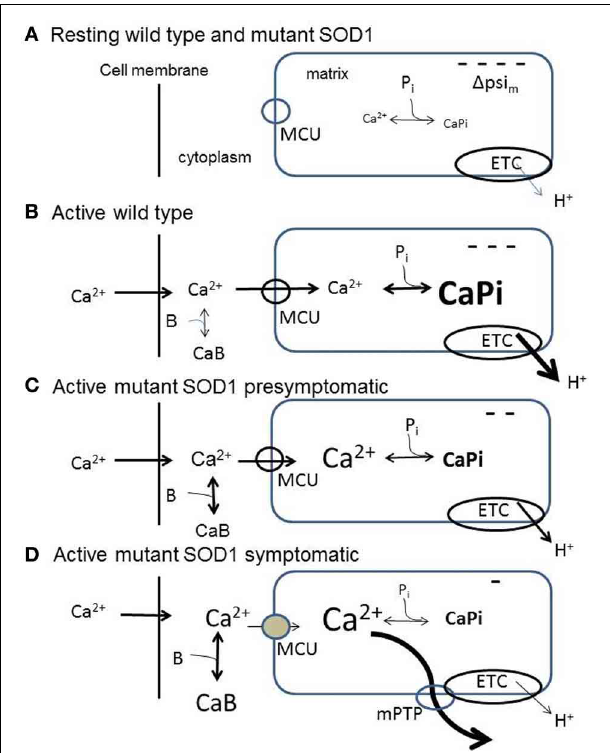
FIGURE 1 | Diagrams summarizing aspects of mitochondrial handling of stimulation-induced Ca 2 + loads in wild-type (B) and in presymptomatic (C) and symptomatic (D) SOD1-G93A motor neurons, inferred from measurements in somata and motor terminals. (A) Resting wild-type and SOD1-G93A motor neurons. (cid:2)(cid:3) m is inside-negative due to H + extrusion by the electron transport chain (ETC). Pi represents dynamic phosphate-dependent matrix Ca 2 + buffering capacity. (B) Wild-type neuron buffering a large stimulation-induced Ca 2 + influx. At least 50% of this influx enters mitochondria via the mitochondrial Ca 2 + uniporter (MCU). The mitochondrial Ca 2 + influx partially depolarizes (cid:2)(cid:3) m , thus increasing ETC activity. Matrix Ca 2 + buffering limits the increase in matrix [Ca 2 + ]. (C) Presymptomatic SOD1-G93A neuron. Much of the incoming Ca 2 + load continues to enter mitochondria. Matrix buffering persists,